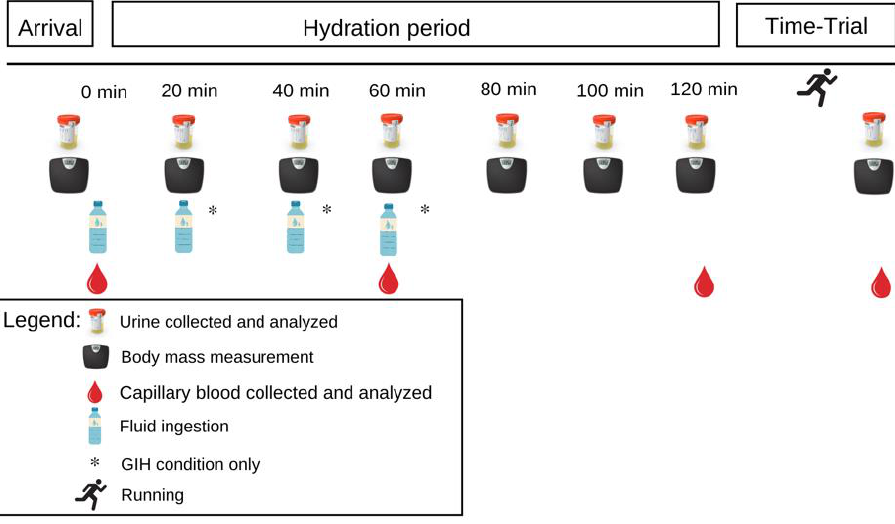
Figure 1. Illustration of the experimental protocol.